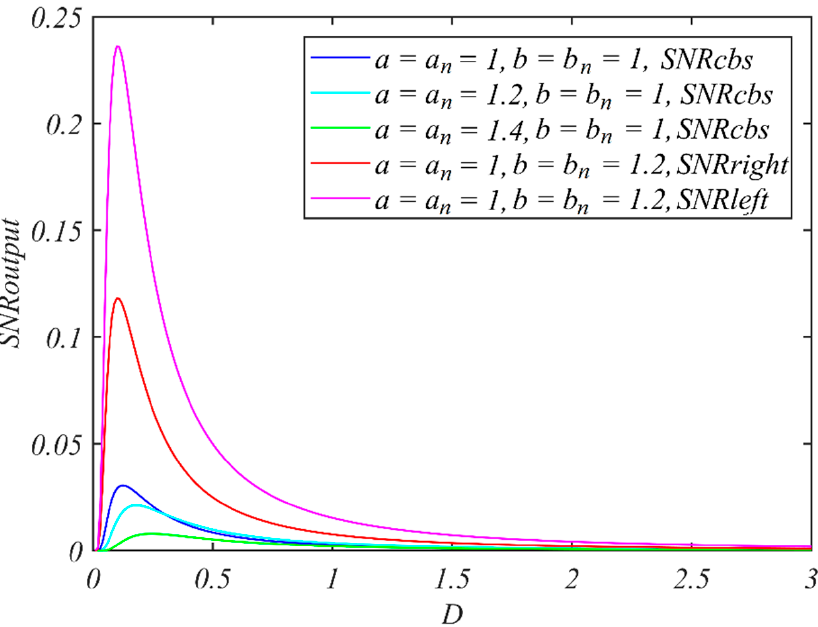
Figure 5. SNR of PNABSR changes with parameters a, b ( A = 0.1, 𝑓 (cid:2868) = 0.01 Hz)